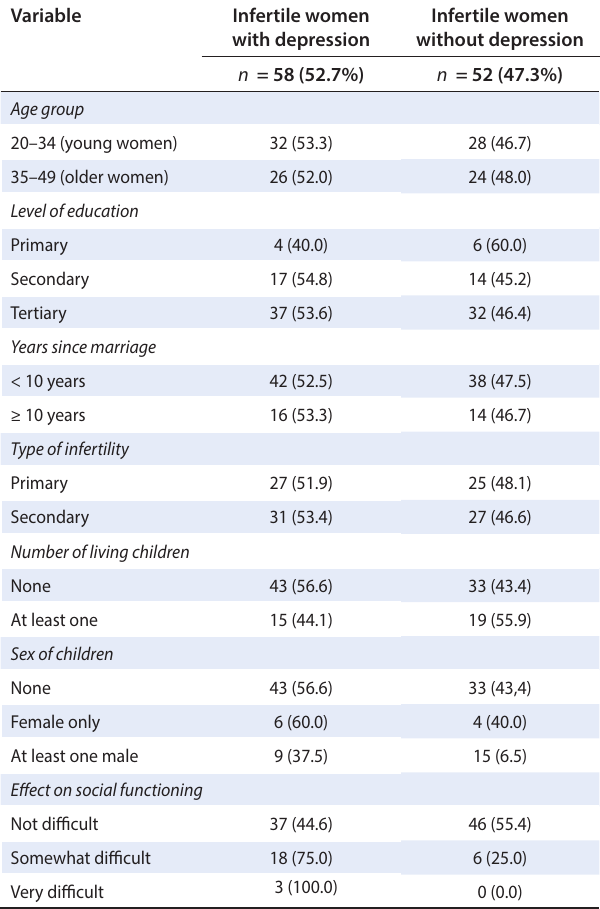
Figure 1: Depression severity. Table 2: Factors associated with depression among infertile